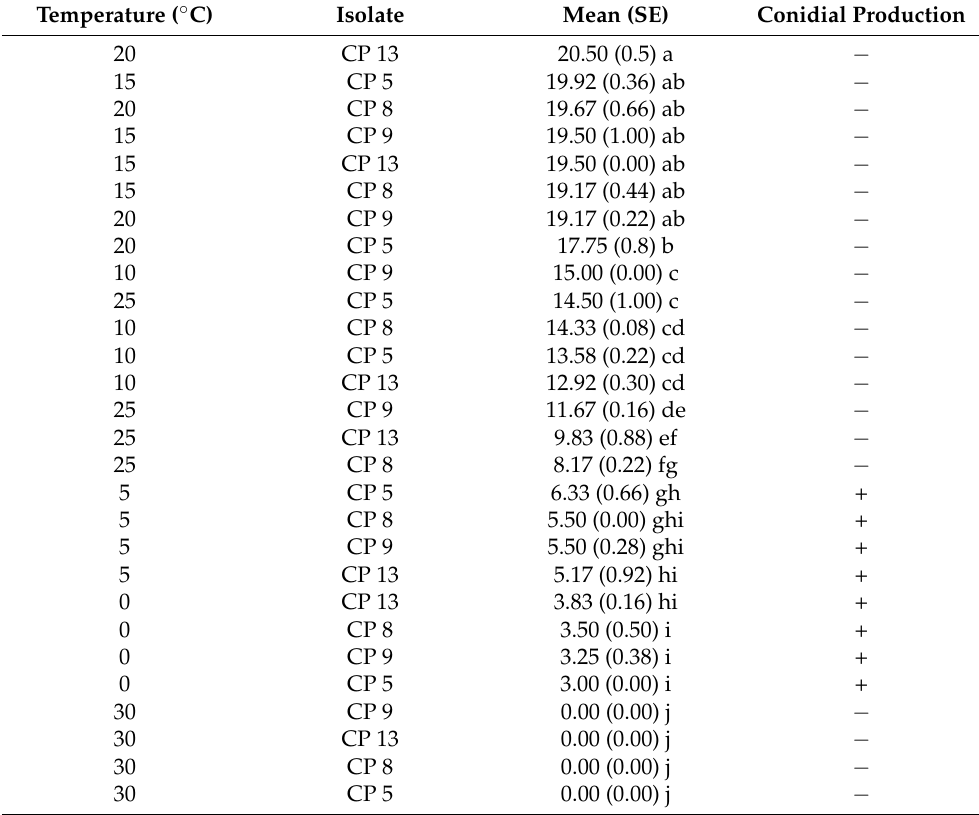
Data represent the average of the isolates. Different letters indicate growth differences for an isolate at different temperatures based on Tukey HSD test ( p < 0.05). Symbol + mean conidia production and symbol − mean no conidial.